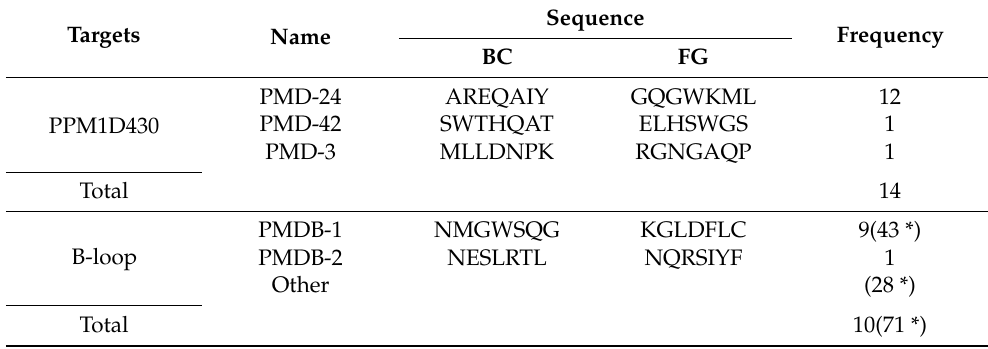
Table 1. Adnectins obtained by the BC-FG randomized adnectin-derived phage display library against PPM1D. The adnectin-displayed phage library in which NNK codons was introduced at seven constitutive residues in the BC and FG loops. Sequence analyses were performed on clones isolated after the screening against full length or B-loop of PPM1D430 using a constructed adnectin- derived phage display library. The sequences of isolated clones and their frequencies were shown. The numbers with asterisks (*) indicate clones identified by PCR with PMDB-1-specific